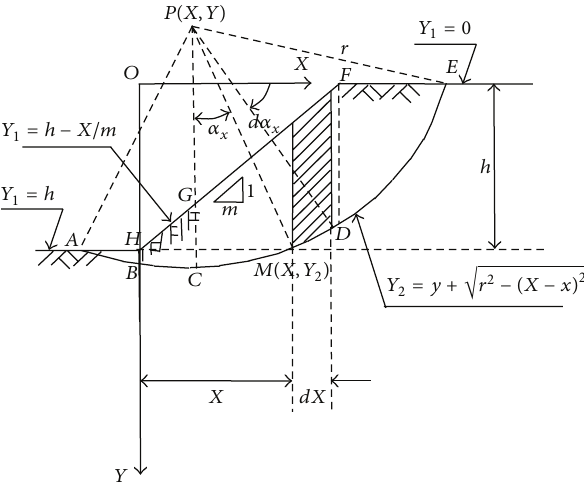
Figure 3: Analytical method to determine the slope safety